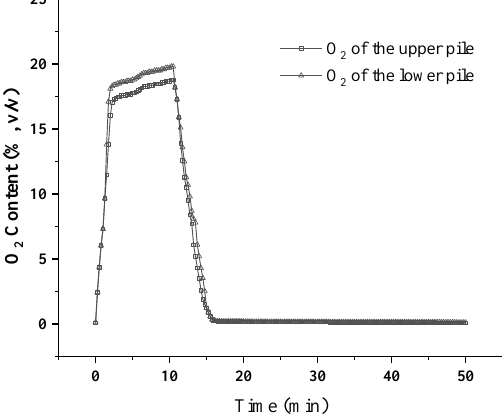
Figure 5. Oxygen concentrations of the composting pile in an aeration cycle.